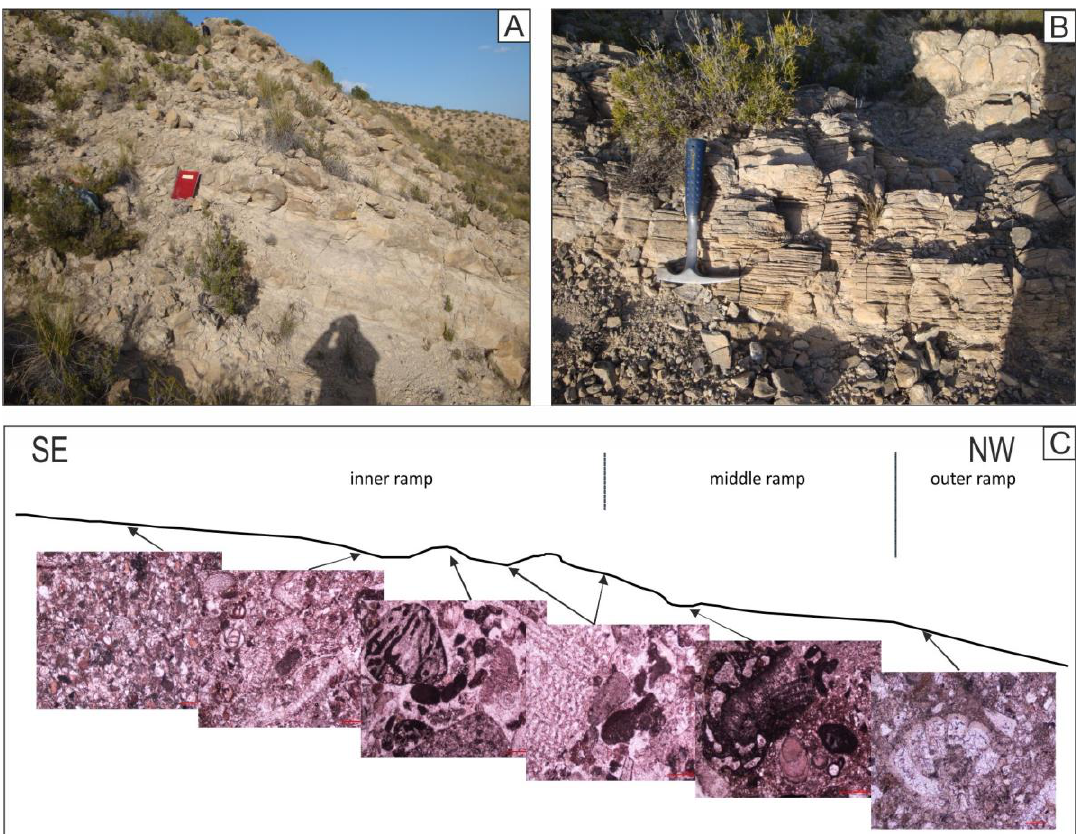
Figure 6. Site 2: The Paleocene Mula Fm in the Doñana area. ( A ) Field outcrops of the Paleocene Mula Fm in the Doñana area. ( B ) Detail of the Mula Fm in the Doñana area. ( C ) Interpretative paleoecological model of the Mula Fm (modified from [1]).